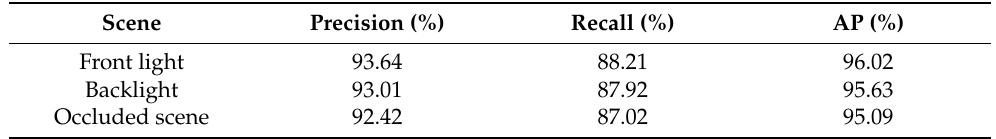
Table 2. The performance of our method under different